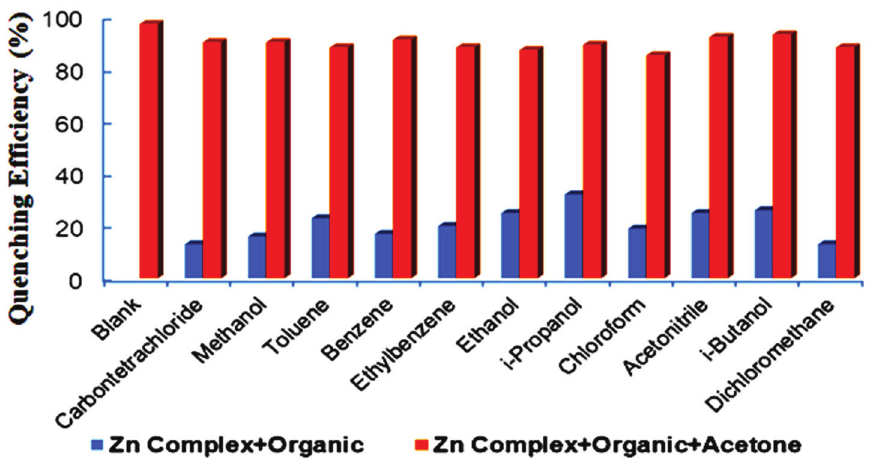
Figure 6. Quenching efficiency of complex {[Zn(bipy) 2 (H 2 O)](ClO 4 ) 2 }( 1 ) upon the addition of different organic solvents, except for acetone (blue) and subsequent addition of acetone (red).